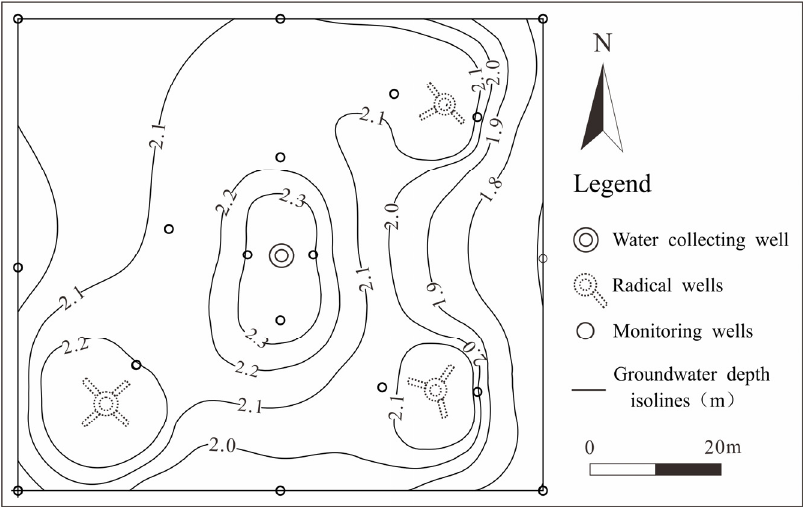
Figure 6. Contours of groundwater depth under the in fl uence of the groundwater control system.